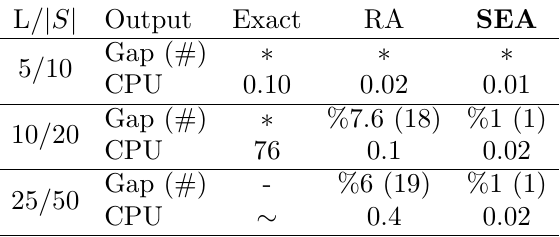
Table 7. Comparison of solution